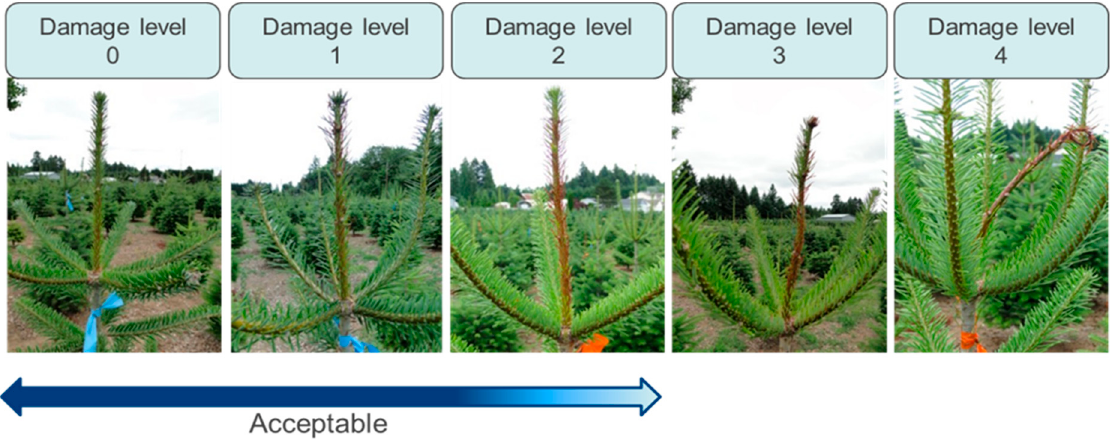
Figure 3. Leader damage ratings.